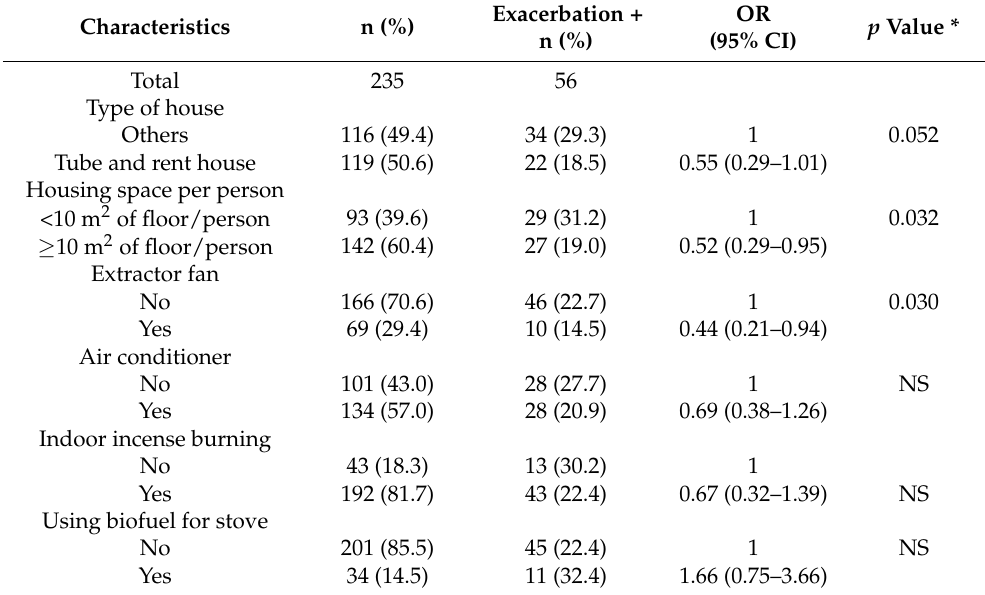
Table 2. Types of house and indoor pollution factors and the risk of